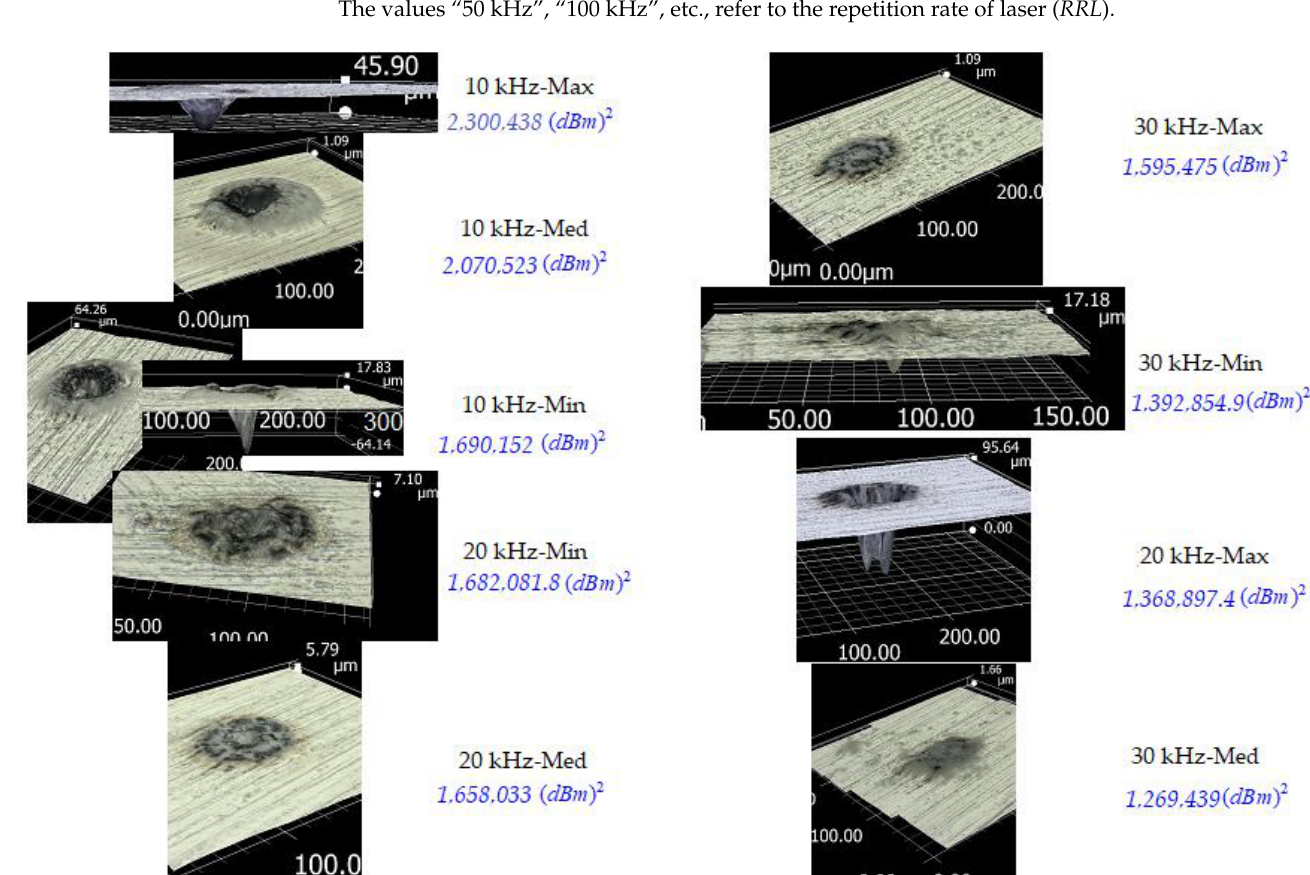
Figure 6. Spatter areas measured by 3D microscope, from the lowest SA (left) to the highest (right). The values “50 kHz”, “100 kHz”, etc., refer to the repetition rate of laser ( RRL ).